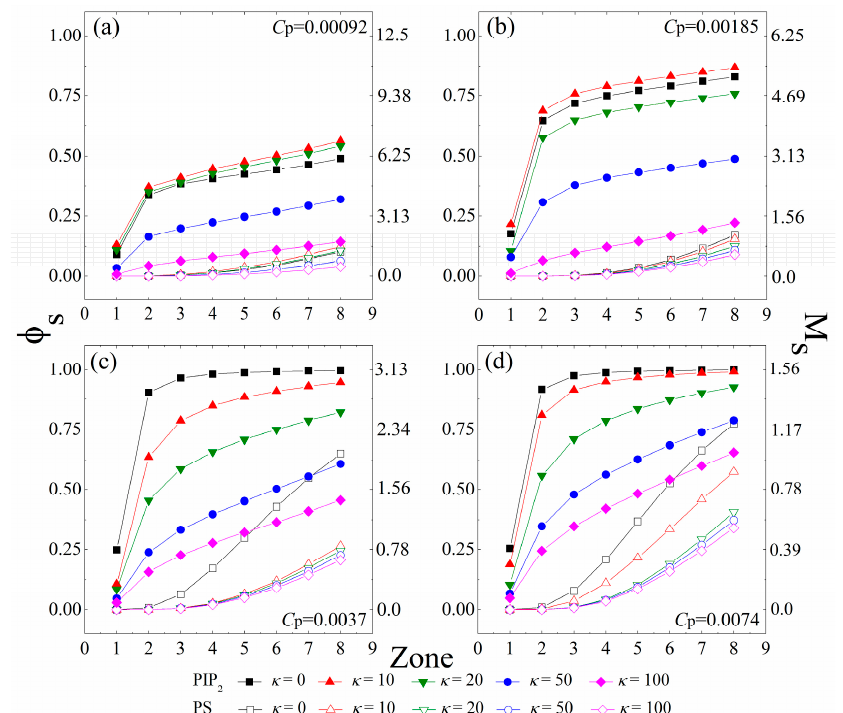
Figure 2. Fraction ( φ s ) of the anionic lipids (PIP 2 , solid symbols; PS, vacant symbols) sequestered in the interaction zones of all anchored polymers, and the number ( M s ) of the anionic lipids (PIP 2 , solid symbols; PS, vacant symbols) sequestered in the zones underneath each anchored polymer. The polymer concentration is set as ( a ) C p = 0.00092; ( b ) C p = 0.00185; ( c ) C p = 0.0037 to ( d ) C p = 0.0074. The